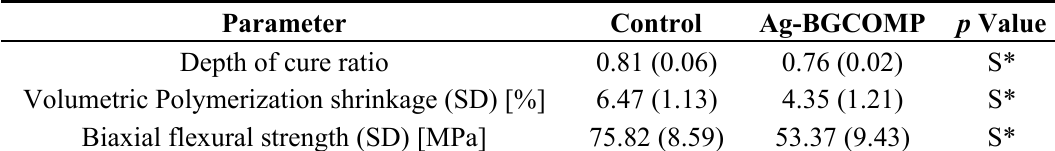
Figure 4. Biaxial flexural strength of control and Ag-BGCOMP. * = statistically significant difference ( p = 0.0001) between the two groups. Error bars represent the standard deviation (SD) calculated in each group. Table 1. Mean values (SD) of the three properties of control and a silver doped bioactive glass (Ag-BGCOMP).